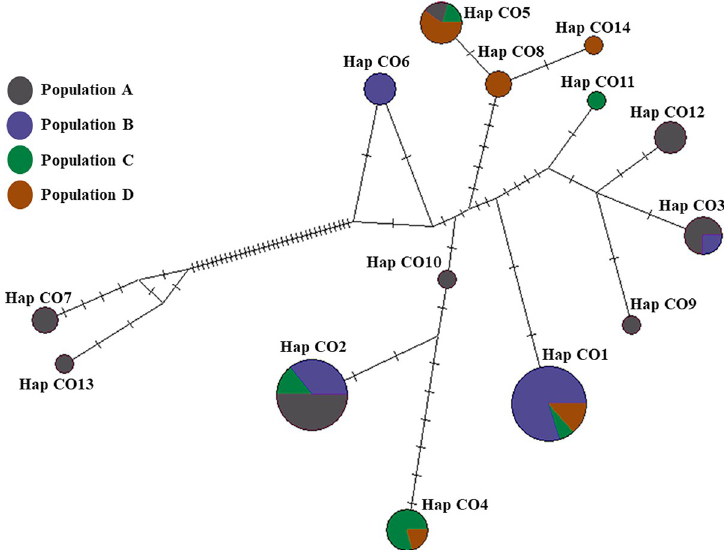
Fig 5. Mitochondrial DNA genealogy for 58 COI sequences of C . siamensis constructed using a median joining network method. Each haplotype is represented by a circle. Sizes of the circles are relative to the number of individuals sharing specific haplotypes. Each mutation between the haplotypes is represented by a bar.